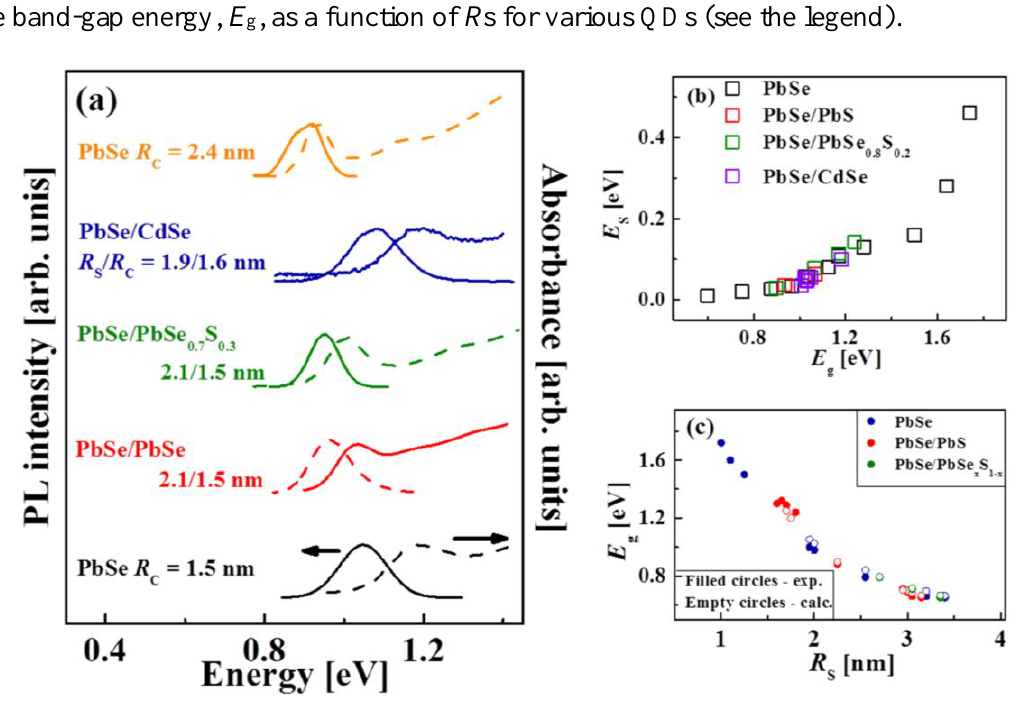
QDs and core/shell QD of various size, R s /R c ratio, and composition (see the legend); ( b ) dependence of Stokes-shift energy, E S , on E g for QDs of different composition (see the legend); ( c ) calculated (empty circles) and experimental (filled circles) values